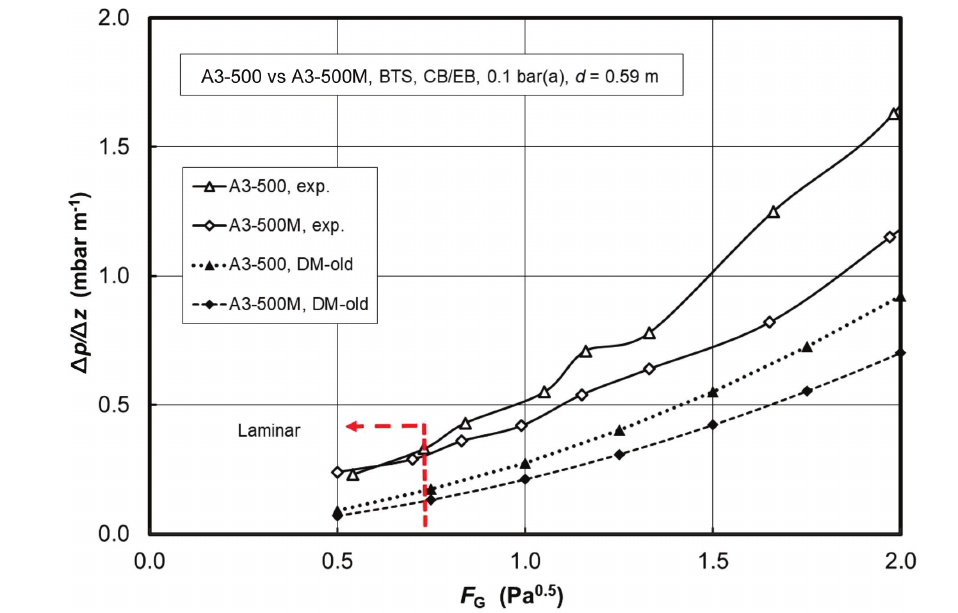
Fig. 12 – Effect of a bend in bottom part of corrugations on the pressure drop of a well-established wire gauze corrugated sheet structured packing, as measured in total reflux tests carried out at Bayer Technology Services, using chlorobenzene/ethylbenzene system at 0.1 bar 16 . Dotted and dashed lines are predictions by original DM, and laminar flow should prevail at F-factors below 0.75 Pa 0.5 .